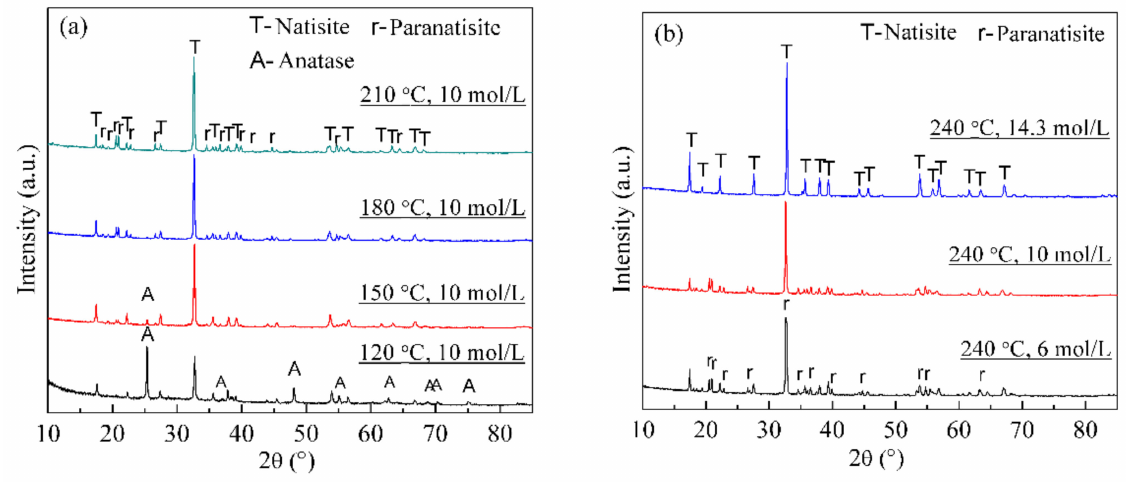
Figure 1. XRD patterns of the hydrothermal products obtained from different temperatures ( a ) and NaOH concentrations ( b